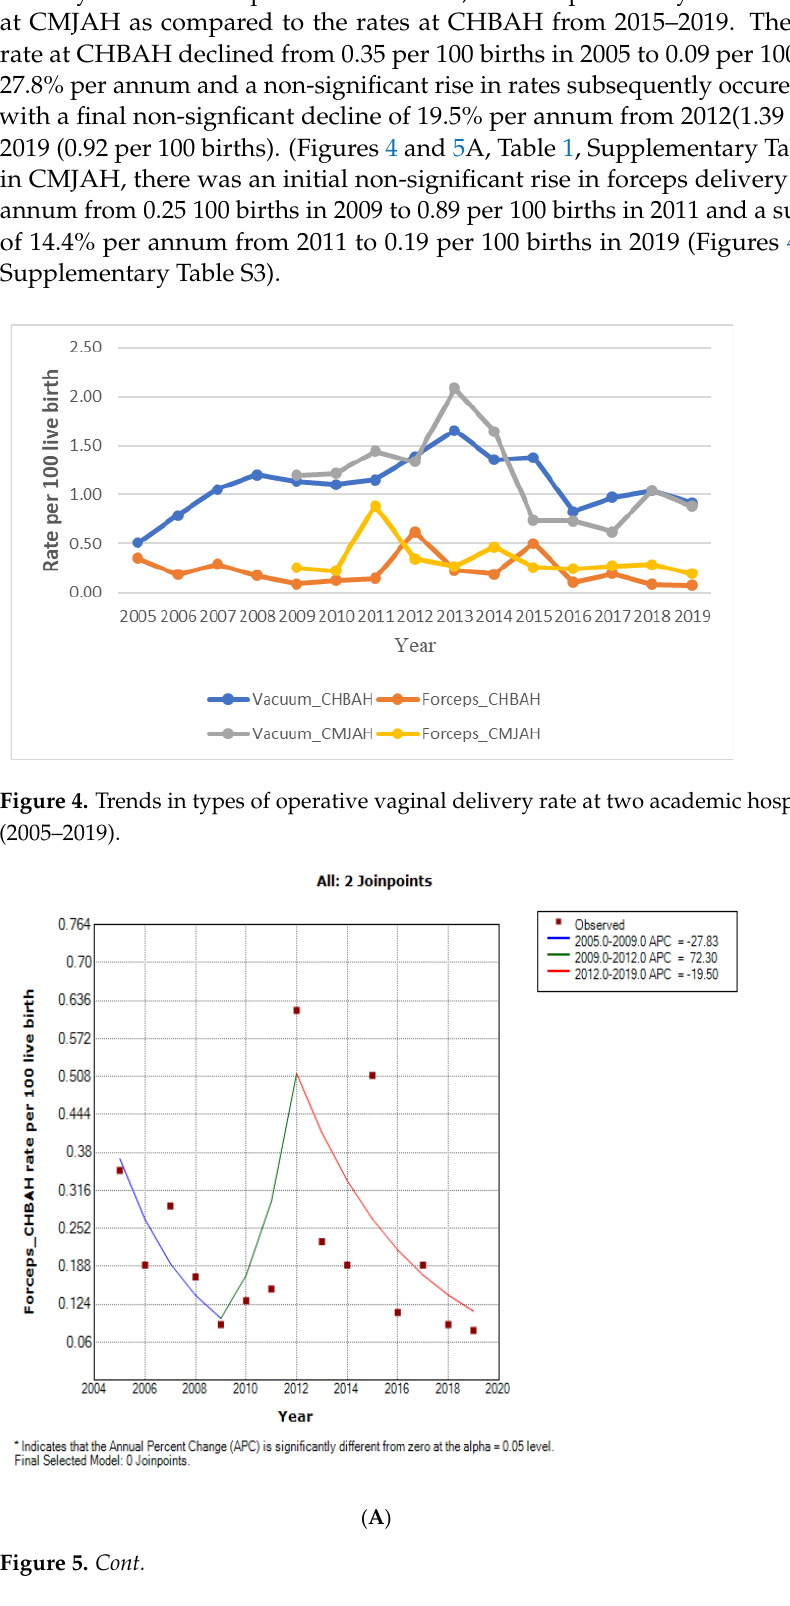
( B ) Figure 5. Join point regression analysis of the trends in forceps delivery ( A ) and Vacuum ( B ) rates at Chris Hani Baragwanath Academic Hospital (2005 – 2019).